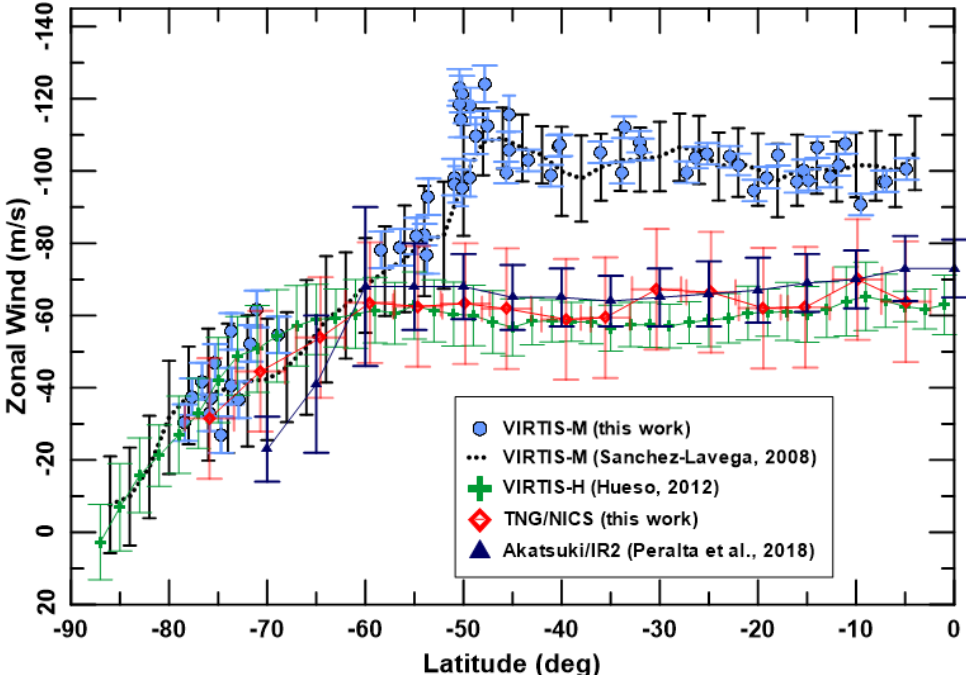
Figure 13. Comparison between two levels of the atmosphere is latitudinal profile of the zonal wind coming from coordinated ground-based TNG/NICS Venus nightside observations (NIR at 2.28 µ m) sensing the bottom of the cloud layer ( ∼ 48 km of altitude) on 11–13 July 2012, and the dayside cloud tops zonal wind velocities obtained from our coordinated space-based observations with VEx/VIRTIS-M on 11 July 2012. For the ground-based case, we used a latitudinal binning of 5 degrees, while for the space-based observations, a 1 degree binning was used. For comparison purposes, we also plot reference results from VEx/VIRTIS-M [5] at cloud tops, VEx/VIRTIS-H IR channel, which senses the bottom of the clouds [21], and also from the Akatsuki IR2 camera